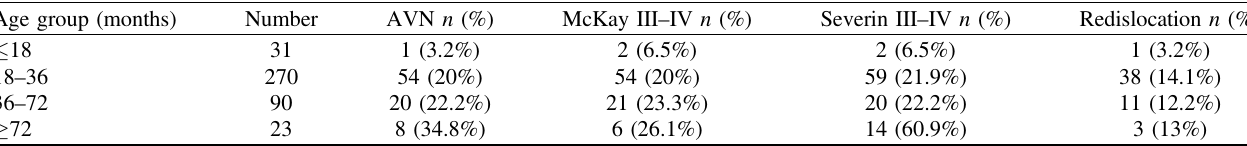
Table 2. Description of results in age group.